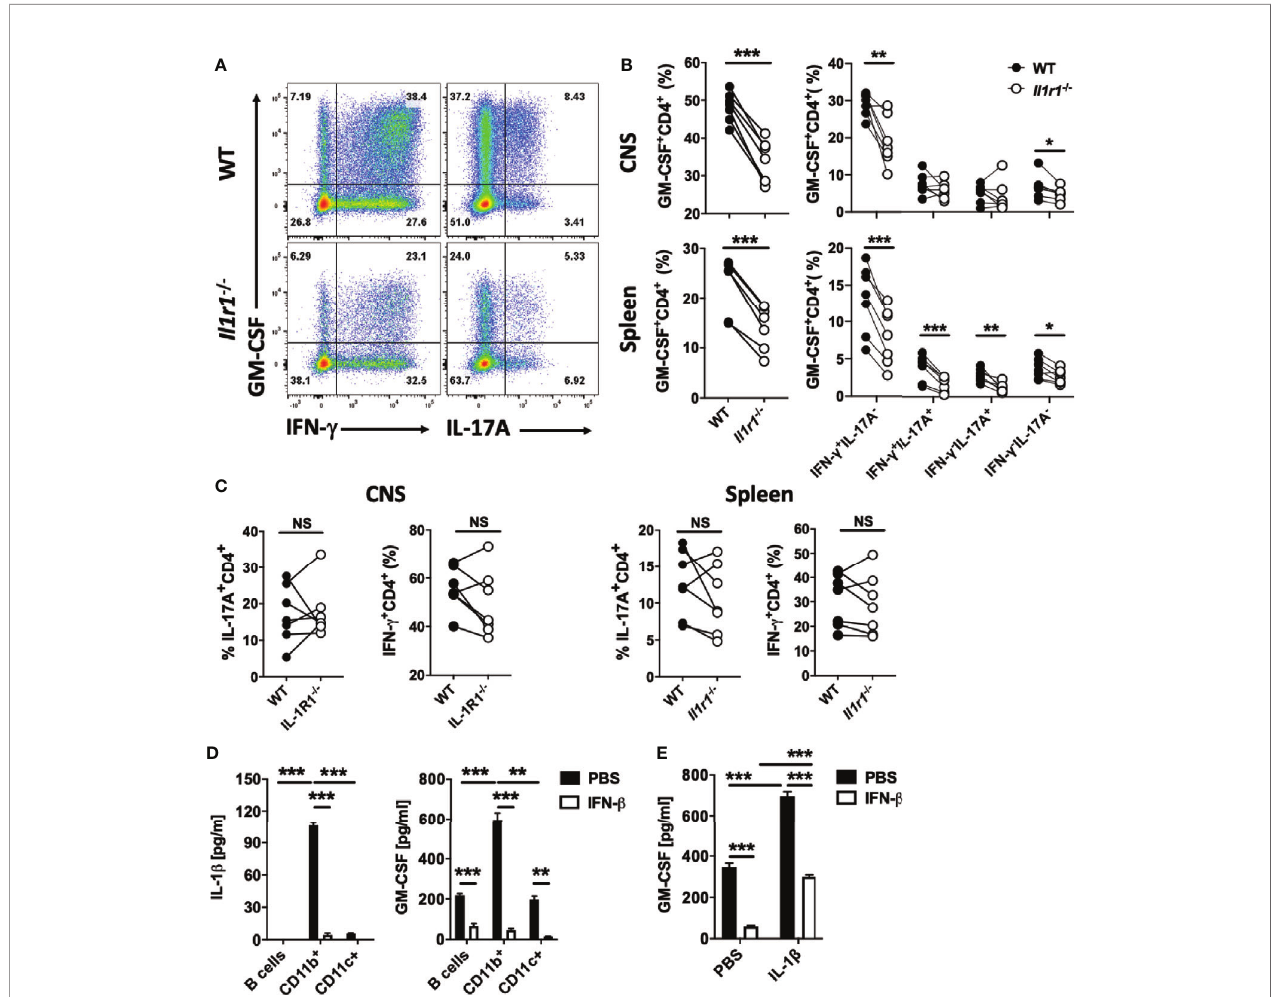
FIGURE 6 | IL-1 b induces GM-CSF expression in Th cells. Splenic WT (CD45.1) and Il1r1 -/- (CD45.2) CD4 + T cells in a 1:1 ratio (total 1 x 10 7 cells) were co- transferred into recipient Rag1 -/- mice. Recipient mice (n=7) were immunized for EAE induction, and cells obtained from the spleen and CNS were analyzed at disease peak. (A) Representative fl ow cytometry dot plots showing GM-CSF, IFN- g , and IL-17A expression by WT and Il1r1 -/- CD4 + T cells from the CNS of mice with EAE. (B) Proportions (%) of GM-CSF + , and different subsets of GM-CSF + CD4 + T cells in WT and Il1r1 -/- CD4 + T cells from the spleen and CNS of mice with EAE. (C) Proportions (%) of IFN- g + , and IL-17A + CD4 + T cells among WT and Il1r1 -/- CD4 + T cells from the spleen and CNS of mice with EAE. (D) Splenic naïve CD4 + T cells were co-cultured with FACS-sorted CD19 + (B cells), CD11b + , or CD11c + cells from WT splenocytes, and activated with anti-CD3/28 Abs, with